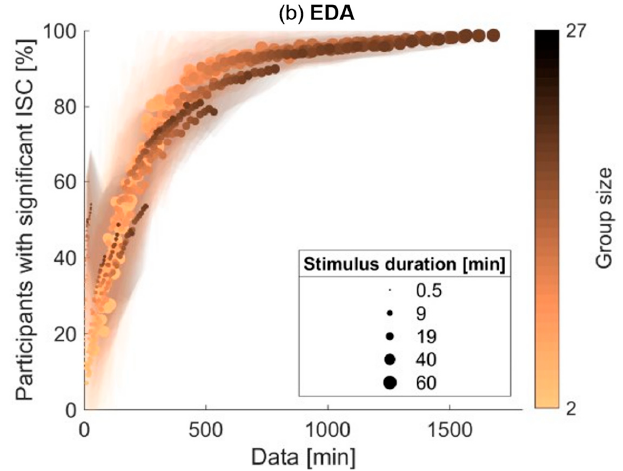
Figure 4. Fraction of participants with significant inter ‐ subject correlations for HR ( a ) and EDA ( b ) as a function of the total minutes of data included in analysis, varied through varying stimulus duration and group size. For each datapoint, the stimulus duration is reflected by the marker size and the group size is reflected by the marker color.